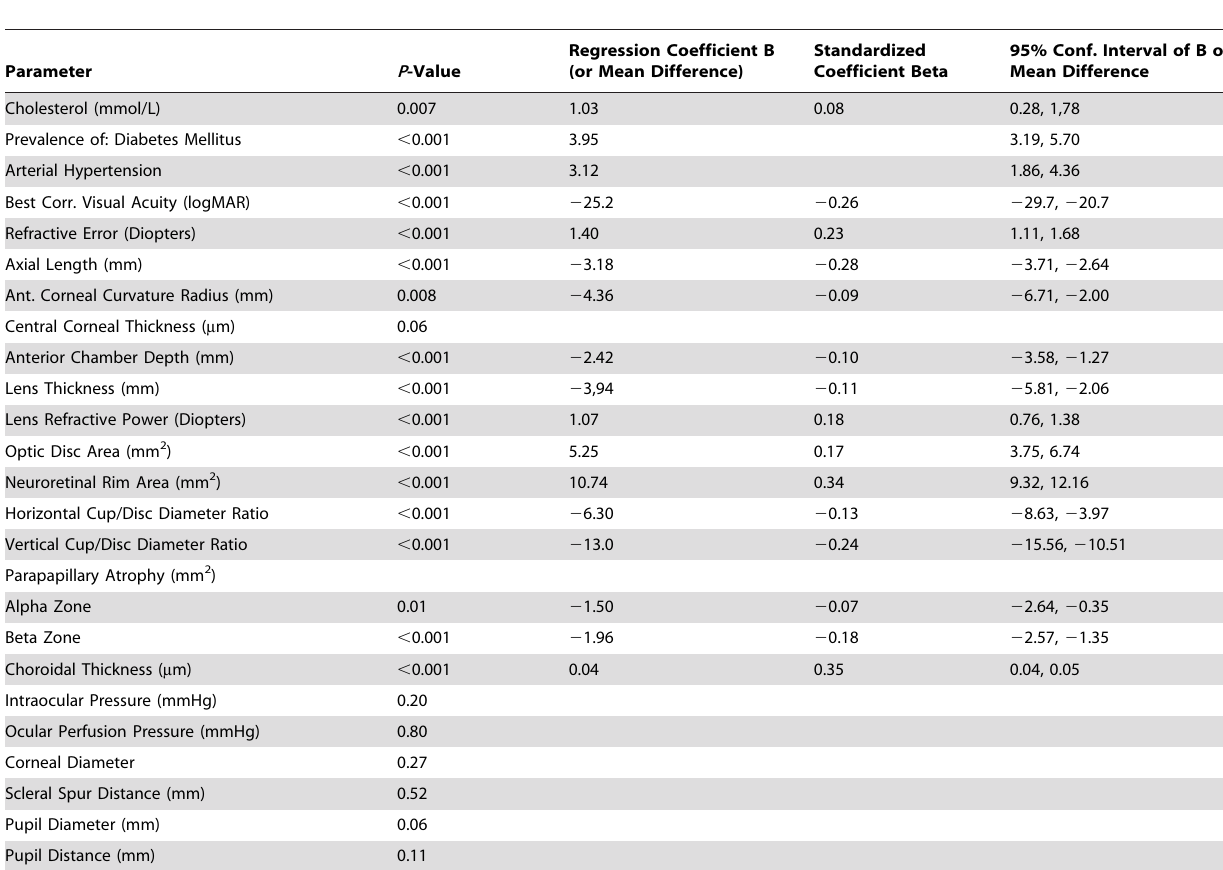
Table 2. Associations between mean global retinal nerve fiber layer thickness as measured by spectral domain optical coherence tomography (iVue SD-OCT) and ocular and systemic parameters in the Beijing Eye Study 2011 (univariate analysis).